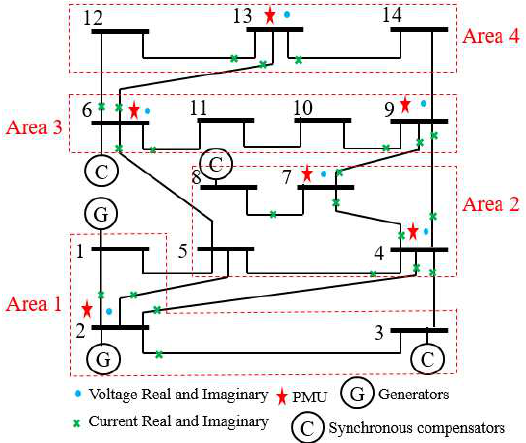
Figure 1. IEEE 14-bus system with phasor measurement units (PMUs) .